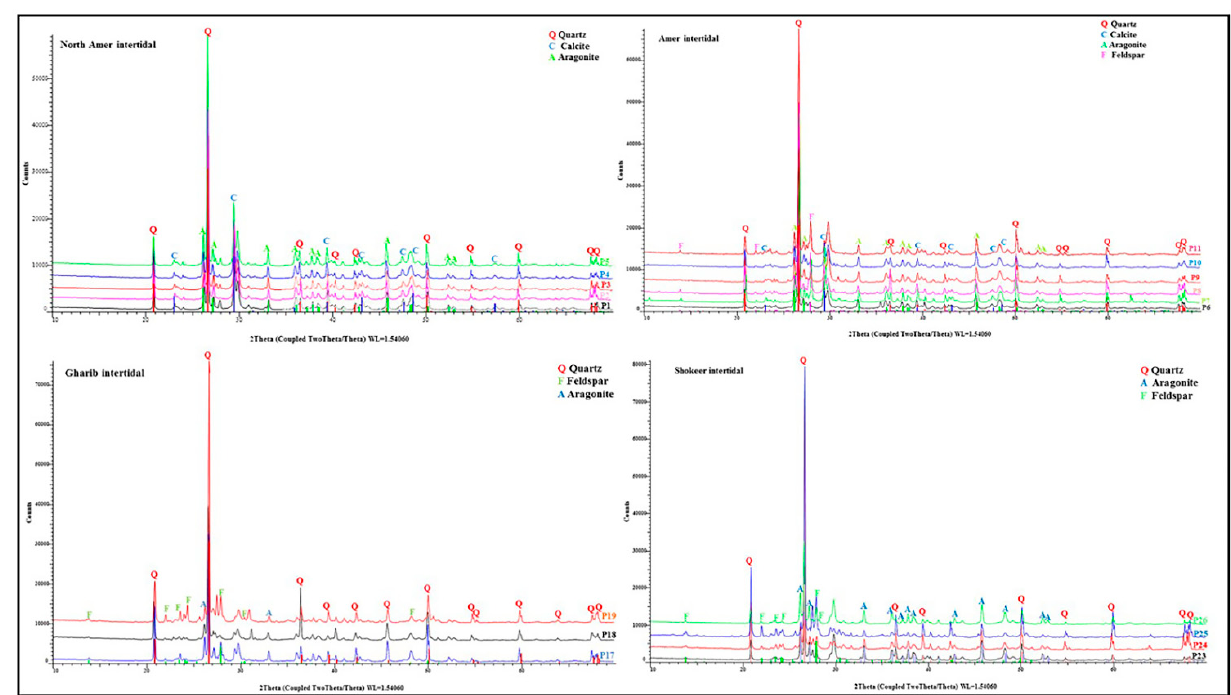
Figure 2. XRD patterns of some sediment samples.